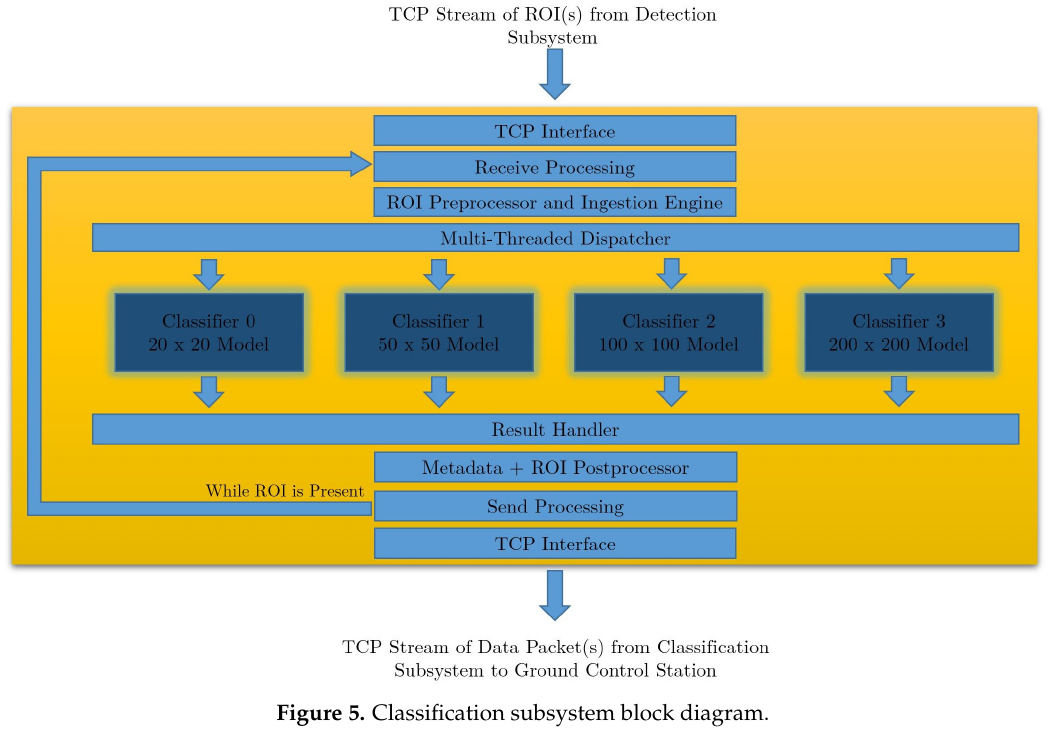
Figure 5. Classification subsystem block diagram.